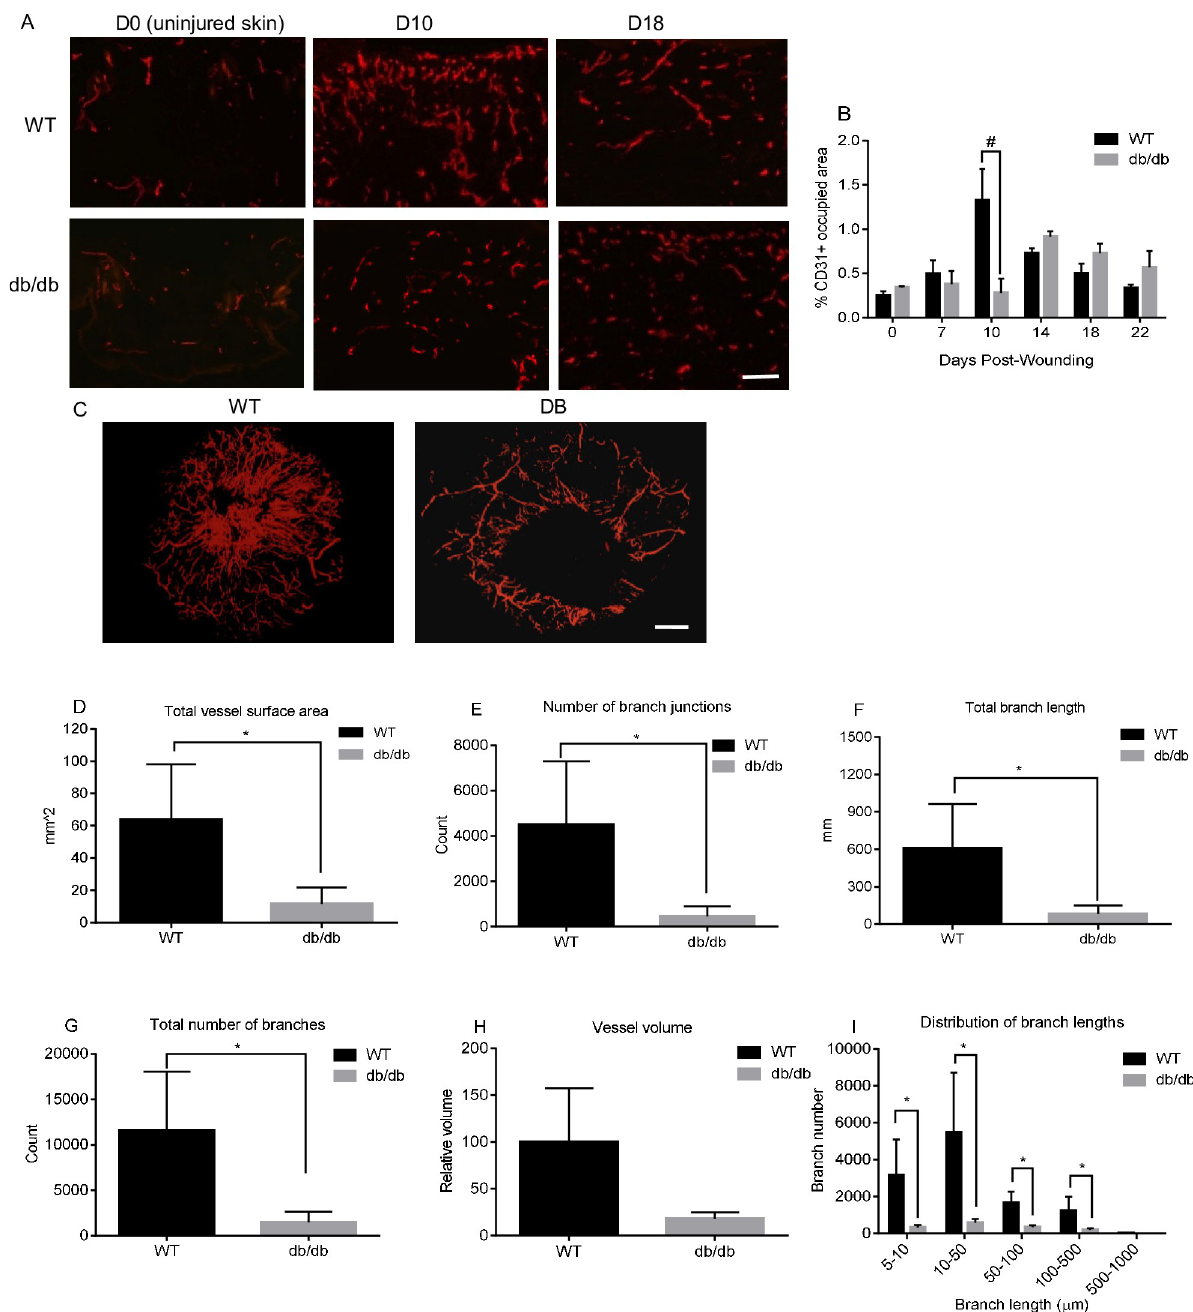
Fig 1. Diabetic wounds show altered 2-D and 3-D vascular architecture. Endothelial cells were identified by CD31 staining in baseline uninjured skin (day 0) and skin wounds at days 7, 10, 14, 18 and 22 post-wounding. A) Representative fluorescence photomicrographs of CD31 staining in the wounds. Scale bar = 100 μ m. B). Wound vascularity. The percent area of the wound edge and wound bed occupied by CD31-positive staining. Mean ± SD, n = 5. #p < 0.01. C). MicroCT images of blood vessels in day 10 wounds of WT and diabetic mice. Scale bar = 1mm. D-I). Total vessel surface area, number of branch junctions, total branch length in (UNIT OF MEASUREMENT), total number of branches, total vessel volume, and the number of branches grouped by branch length, respectively, based on microCT image analysis. � p < 0.05. n = 4 in WT group and 6 in diabetic